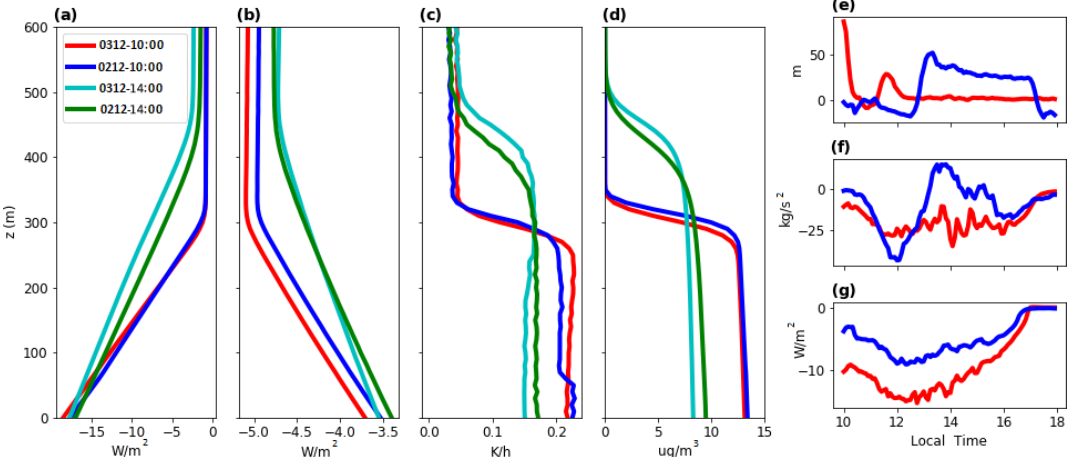
Figure 8. Change (surface aerosol – no aerosols) in (a) downwelling and (b) upwelling SW radiation, (c) SW heating rate and (d) BC concentrations for simulations on 3 December (red and cyan) and 2 December (blue and green) at 10:00 (red and blue) and 14:00 (cyan and green). (e–g) Change (surface aerosol – no aerosols) in (e) PBL height, (f) vertical integral of turbulent kinetic energy (TKE) and (g) sensible heat flux for 3 December (red) and 2 December